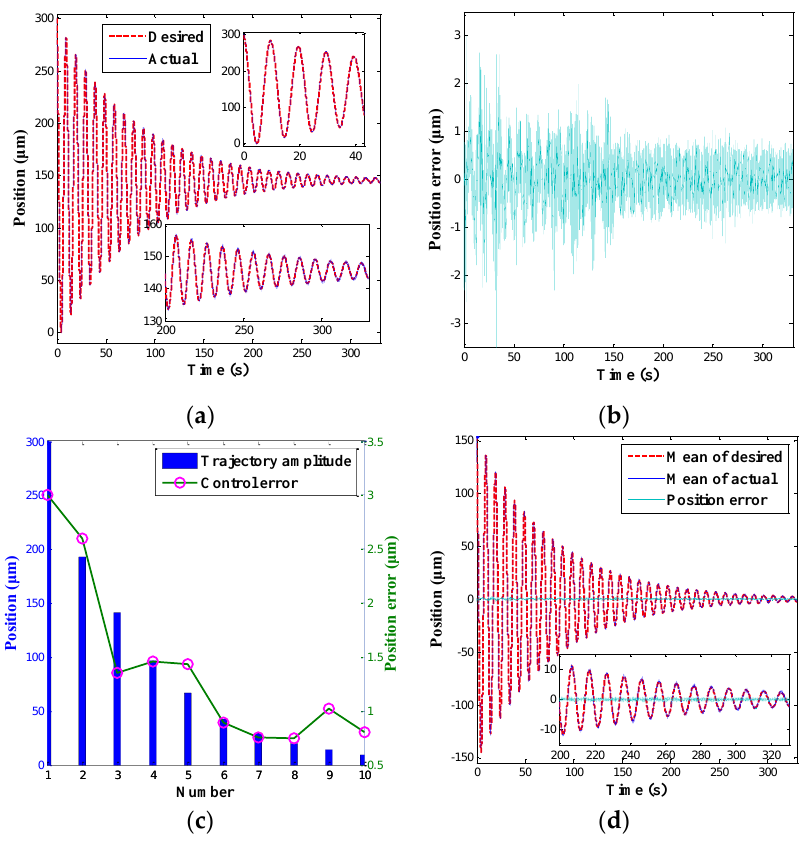
Figure 14. Position control results of a multi-amplitude trajectory. ( a ) Position tracking result; ( b ) Position tracking error; ( c ) Position error versus trajectory amplitude; and ( d ) Position error versus mean of the desired trajectory.